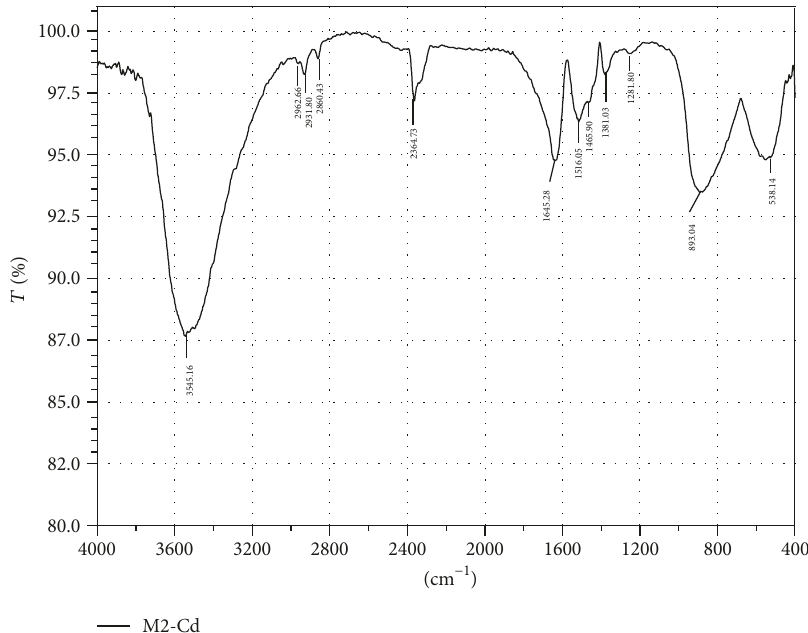
O after adsorption of cadmium. 2 3